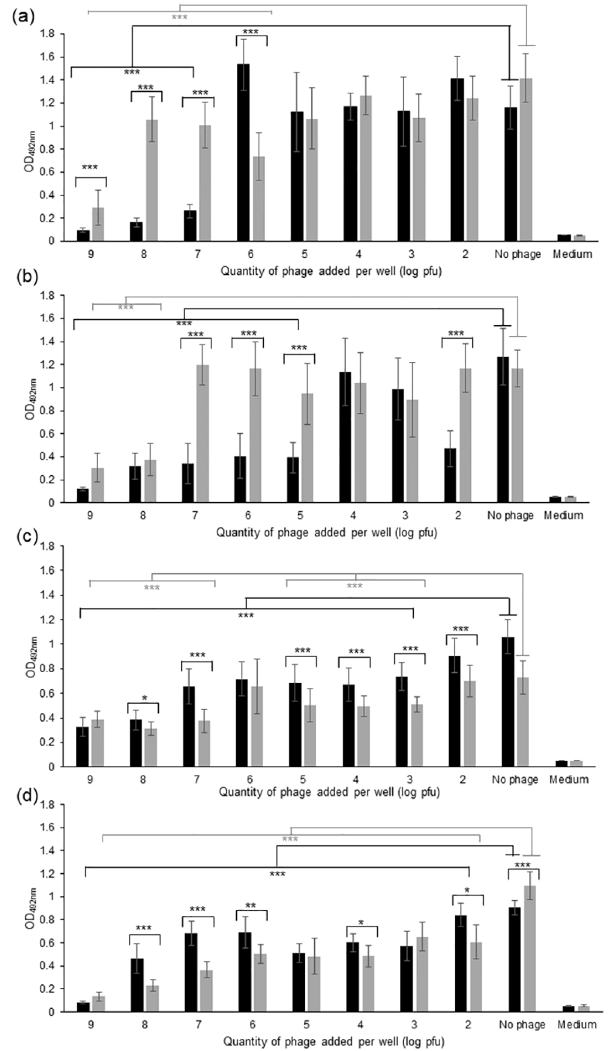
Fig 5. Effect of single phages ɸ APCEc01 (a), ɸ APCEc02 (b), ɸ APCEc03 (c), and a three-phage cocktail (d) on a 24 h-biofilm formed by E . coli strain DPC6051, after 24 h ( ■ ) and 48 h ( ■ ) of contact between phage and bio fi lm. Bio fi lm activity was assessed by OD 492nm measures after treatment with XTT supplemented with menadione. *** p < 0.001; ** p < 0.01; * p <